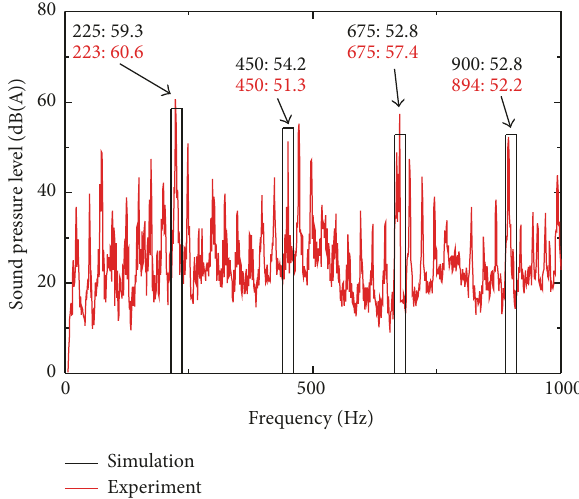
Figure 15: Comparisons of simulated and measured sound pressure